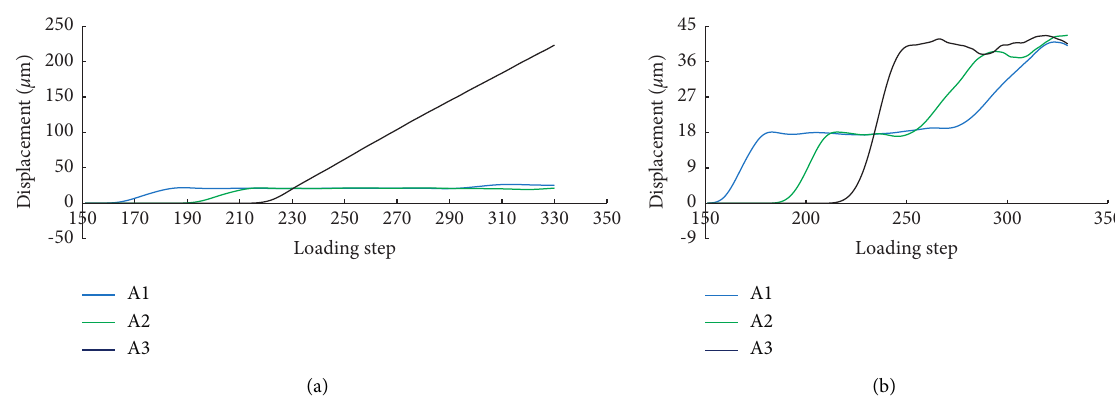
Figure 10: Displacement characteristics of points A1, A2, and A3 in the two numerical models. (a) Numerical model without bolt. (b) Numerical model with